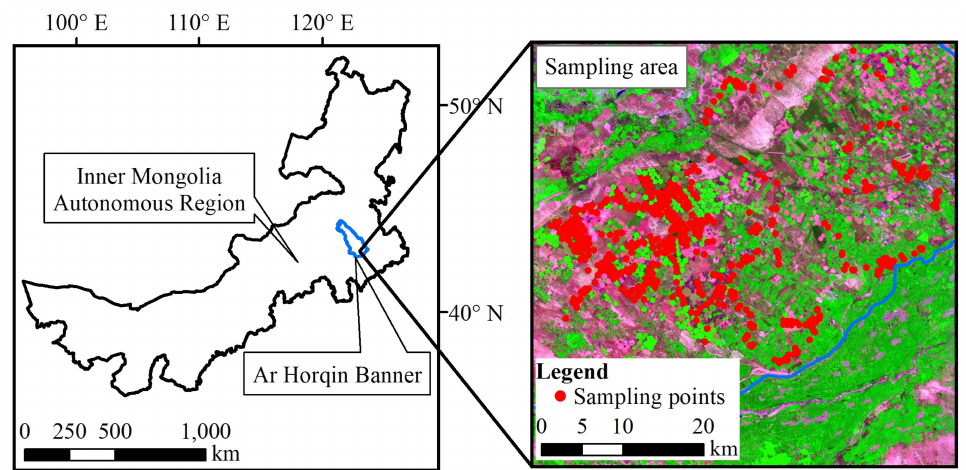
Figure 1. Location of the study area.